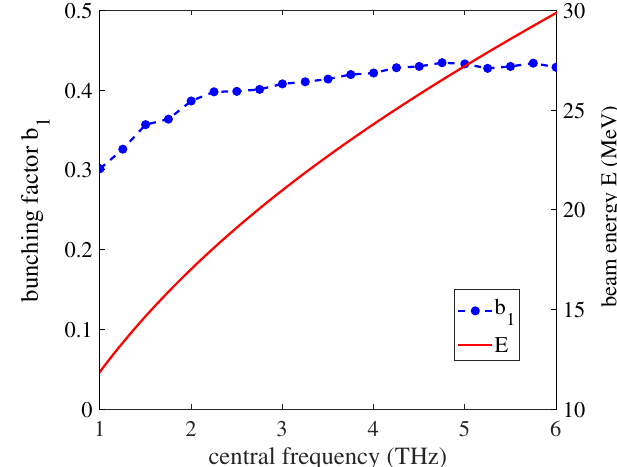
FIG. 4. Bunching factor at fundamental wavelength for various horizontal divergence and emittance.